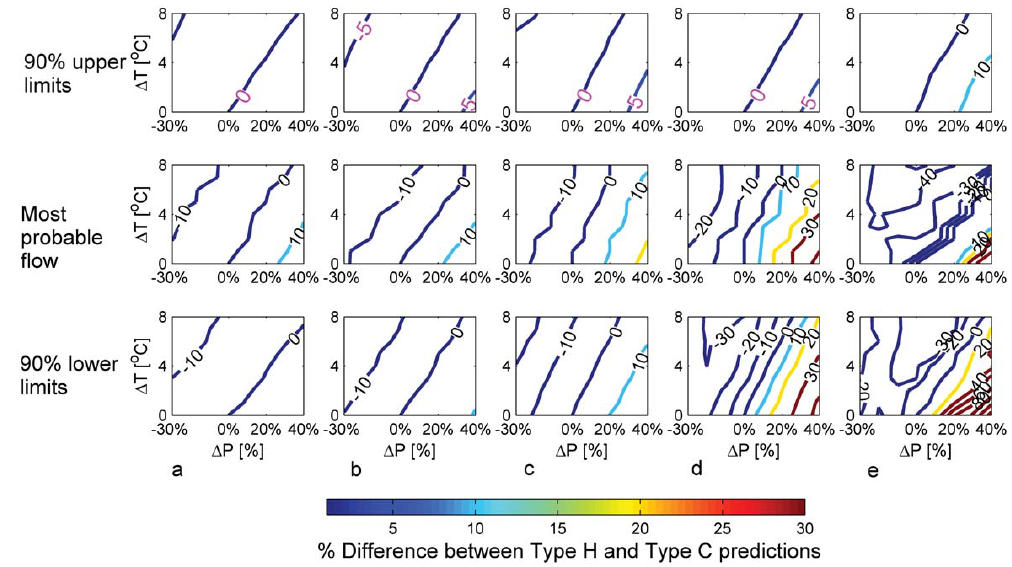
Fig. 6. Contour plots to illustrate the difference in Type H and Type C predictions. The difference between the 90% upper limits, most probable flow, and the 90% lower limits is calculated as a percentage of the prediction for the historical climate for: (a) Lochsa, (b) Lower Androscoggin, (c) Escambia, (d) Meramec, (e)